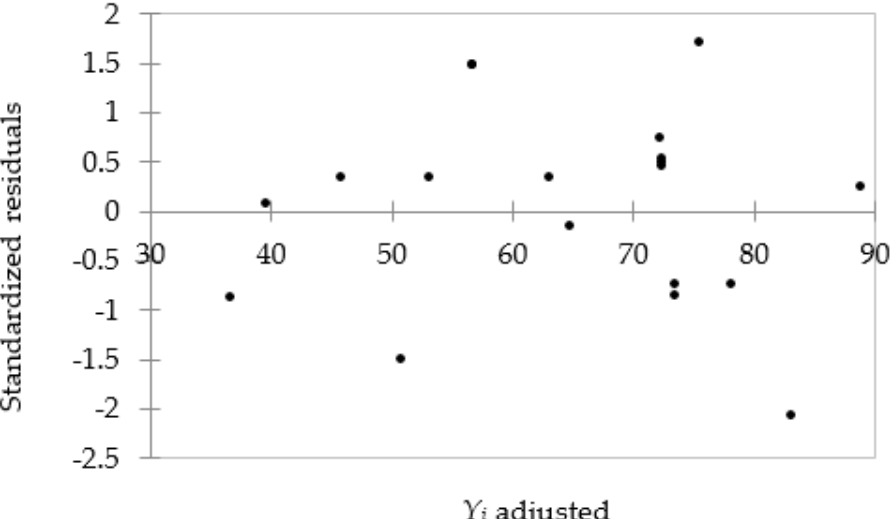
Figure 4. Diagram of standardized residuals of predicted FAME yield.